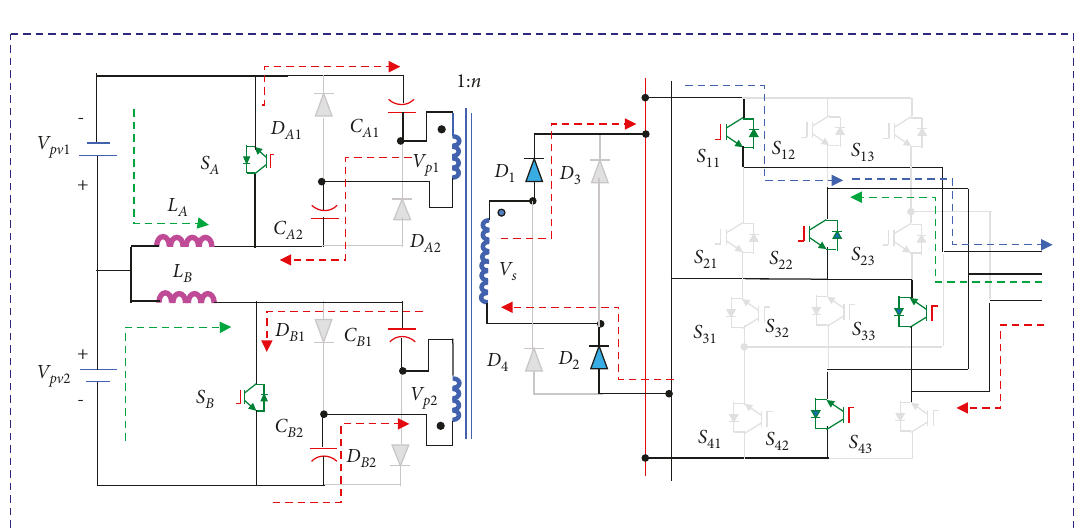
Figure 7: Equivalent circuit of mode 3